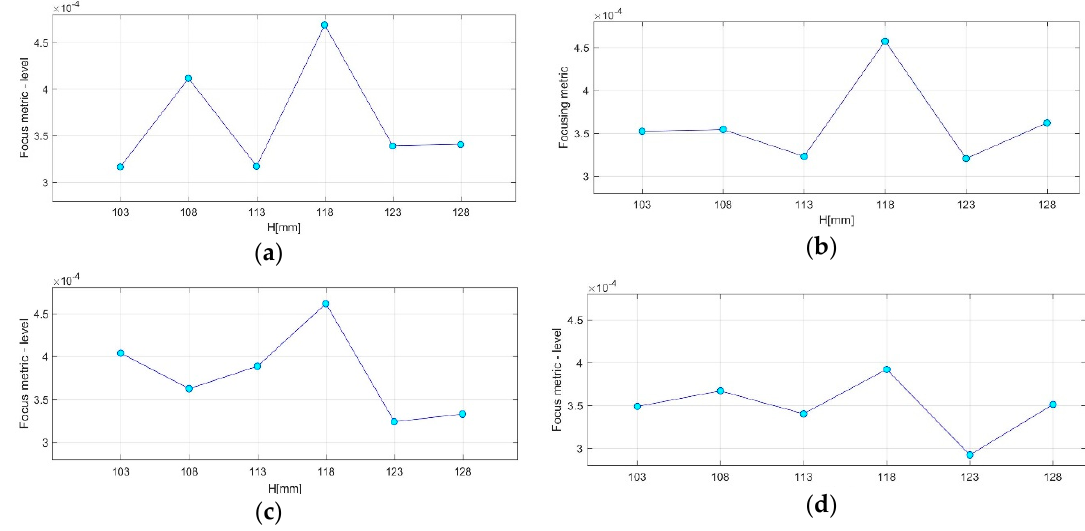
Figure 23. Imaging focusing analysis on 3D multi-H data: ( a ) Rotational position #1—Test Date 1; ( b ) Rotational position #1—Test Date 2; ( c ) Rotational position #2—Test Date 1; ( d ) Rotational position